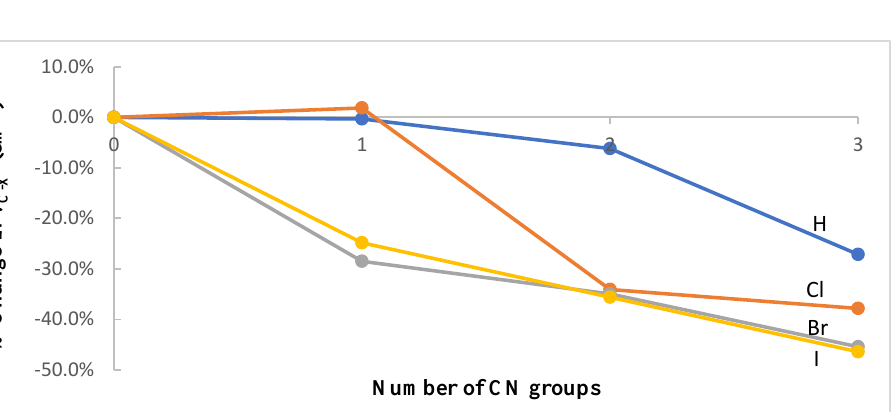
Figure 5. Percent change in the harmonic stretching frequency of the C-X bond, ν C-X , as a function